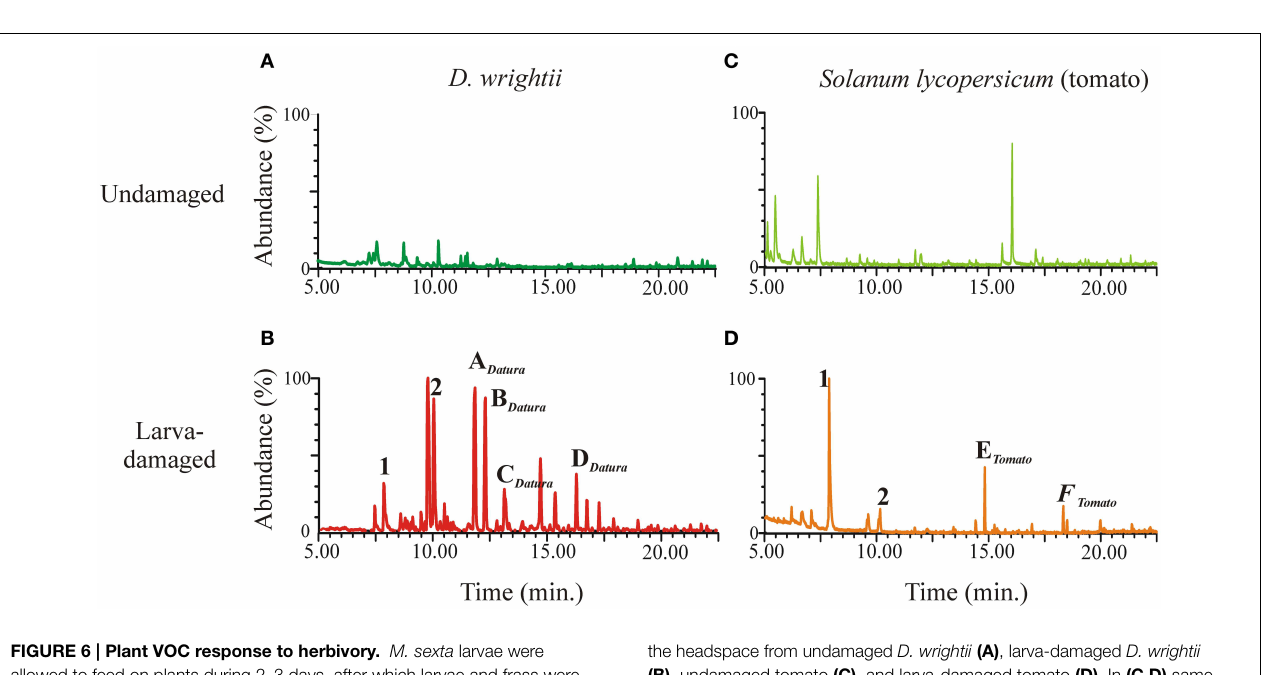
FIGURE 6 | Plant VOC response to herbivory. M. sexta larvae were allowed to feed on plants during 2–3 days, after which larvae and frass were removed and vegetative VOCs collected and analyzed via GC-MS as described in Reisenman et al. (2013). Representative ion chromatograms of